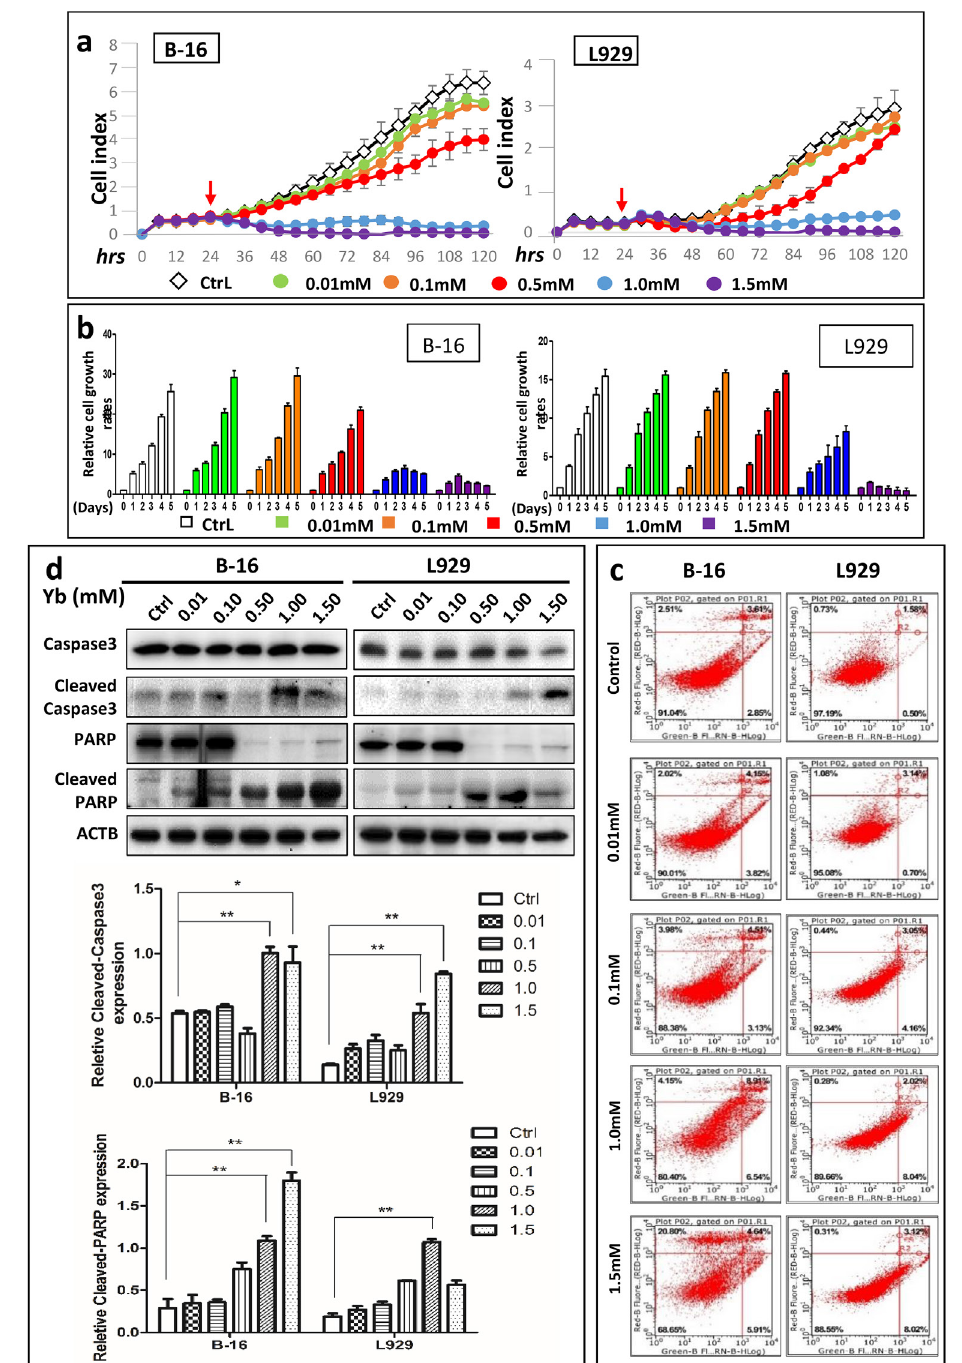
Figure 6: Yb 3+ induces higher apoptosis rates in B-16 cells than in L929 cells. (a) RTCA assay results of B-16 and L929 cells in medium containing Yb 3+ at different concentrations. Cells were first cultured in regular medium for 24 h (red arrow) and then treated with the Yb 3+ ion. (b) Relative cell growth of B-16 and L929 cells at different timepoints (1, 2, 3, 4, and 5 days) obtained from the RTCA data. (c) Flow cytometry results of B-16 and L929 cells treated with medium containing different concentrations of Yb 3+ for 24 h. (d) Western blot of apoptosis marker proteins (caspase3 and PARP and their cleaved forms) in B-16 and L929 cells treated with medium containing different concentrations of Yb 3+ for 24 h. Relative expression of Cleaved-PARP and Cleaved Caspase3 in B-16 and L929 cells based on the western blot results. *p < 0.05, **p <